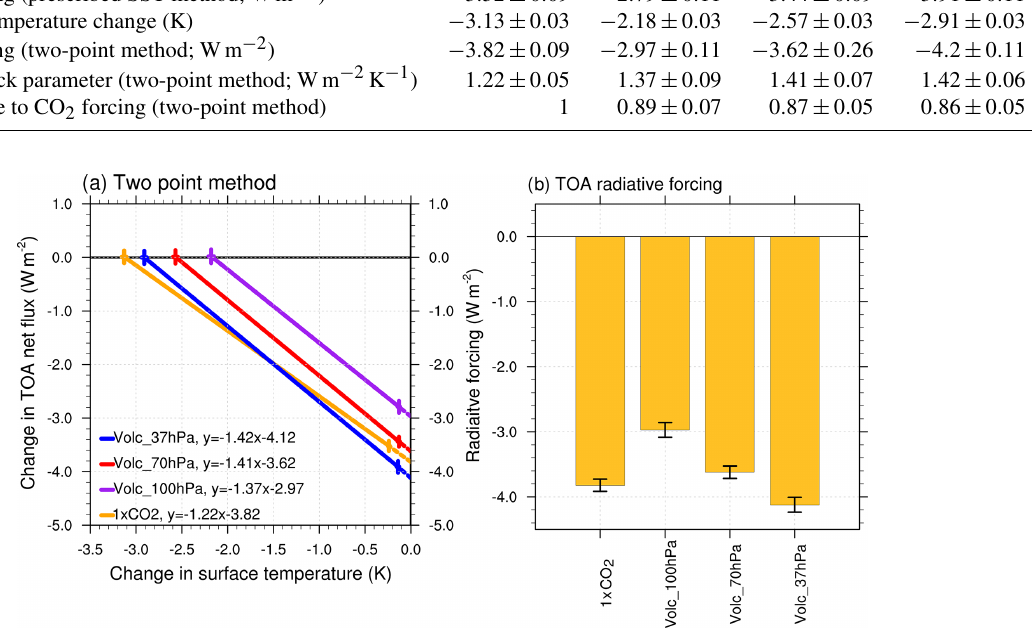
Figure 2. (a) The two-point method for estimating radiative forcing and feedback parameter (Sect. S1). Change in global and annual mean surface temperature and TOA radiative imbalance from the slab ocean (points on the left) and prescribed SST (points on the right) simulations relative to the 2XCO2 simulation. The climate feedback parameter (slope of the lines) and the effective radiative forcing (intercept on the y axis on the right) for CO 2 change (1XCO2–2XCO2) and all stratospheric sulfate experiments can be inferred from the linear regression relationships shown in the figure legends. Horizontal and vertical bars show 2 standard errors of the annual mean differences in surface temperature and radiative forcing relative to 2XCO2 experiment, respectively. The standard errors are estimated using 30 annual means for prescribed SST simulations and 60 annual means for slab ocean simulations. (b) The global annual mean TOA radiative forcing at top of the atmosphere relative to the 2XCO2 experiment, estimated using the two-point method as illustrated in panel (a) . The error bars represent 2 standard errors calculated from 30 annual means of the difference from the 2XCO2